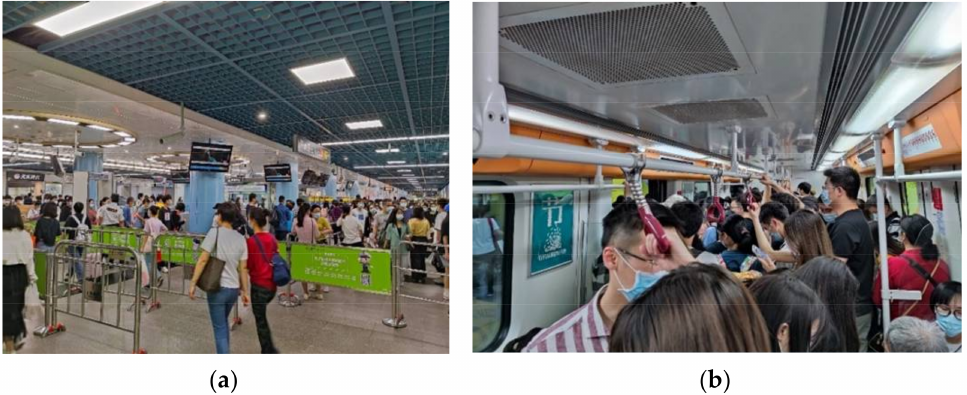
Figure 2. Passengers lining up into the check point ( a ) and passengers in the carriage ( b